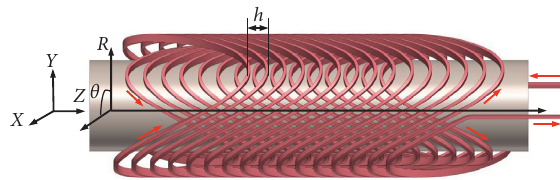
Figure 1: Conceptual view of CCT quadrupole winding.